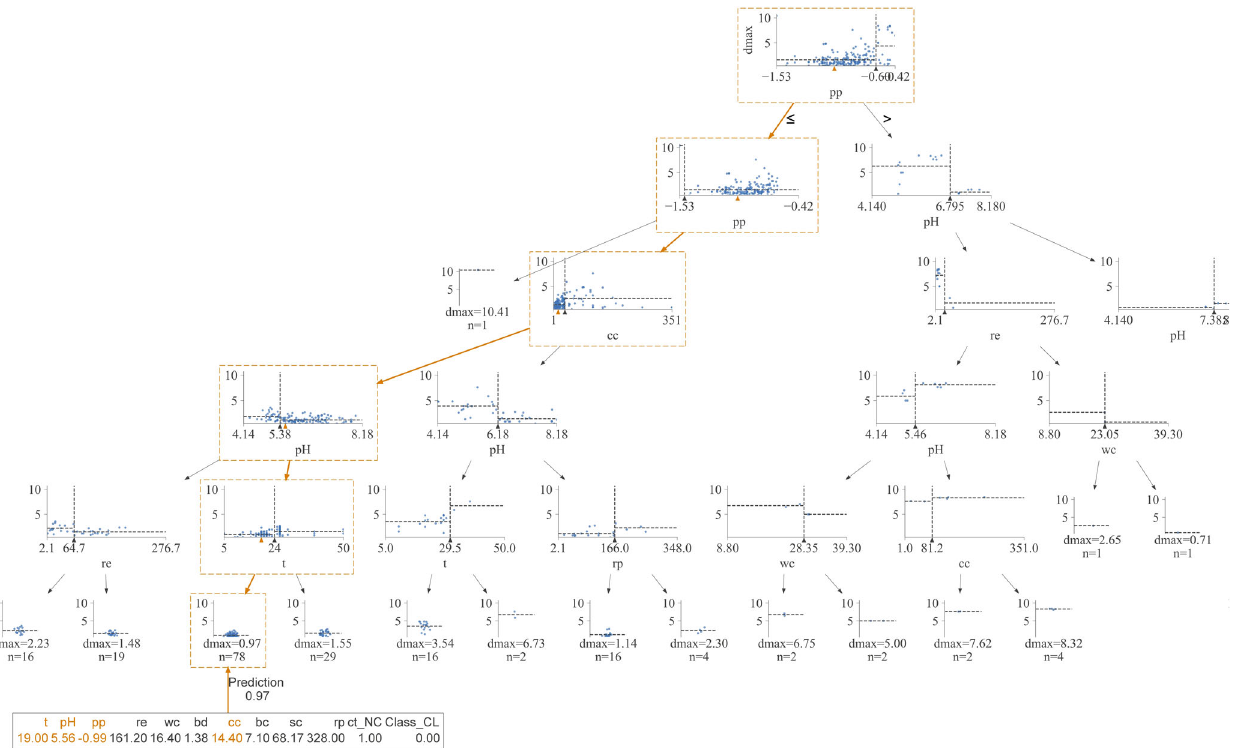
Fig. 7 Visualization of decision trees. The splitting logic for the fi rst six layers of the part of the decision tree generated by AdaBoost, and the variables that have been calculated are marked in yellow in the bottom box.